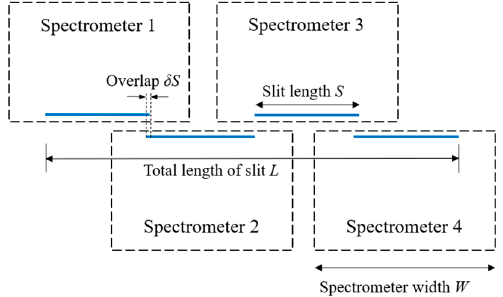
Figure 4. Splicing of spectrometers.